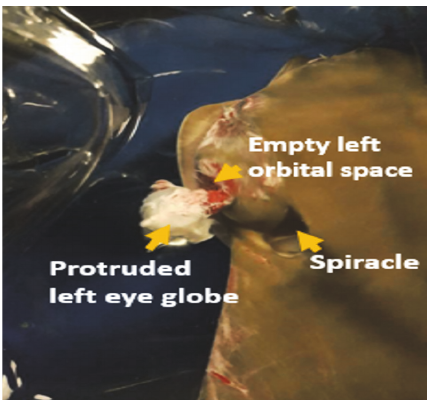
Figure 1: Protrusion of left eye globe from its orbit attached to the optic nerve with its adjacent connective tissue, indicating exposed left eye orbital space and teared periocular tissue. Hyphema cannot be viewed from this angle.